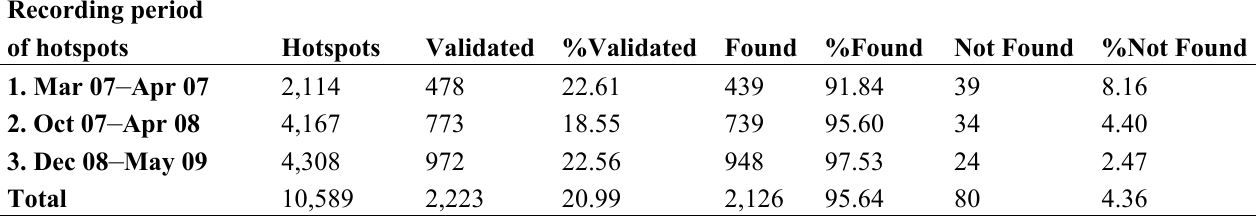
Table 2. Hotspot validation summary within protected areas by 138 forest fire